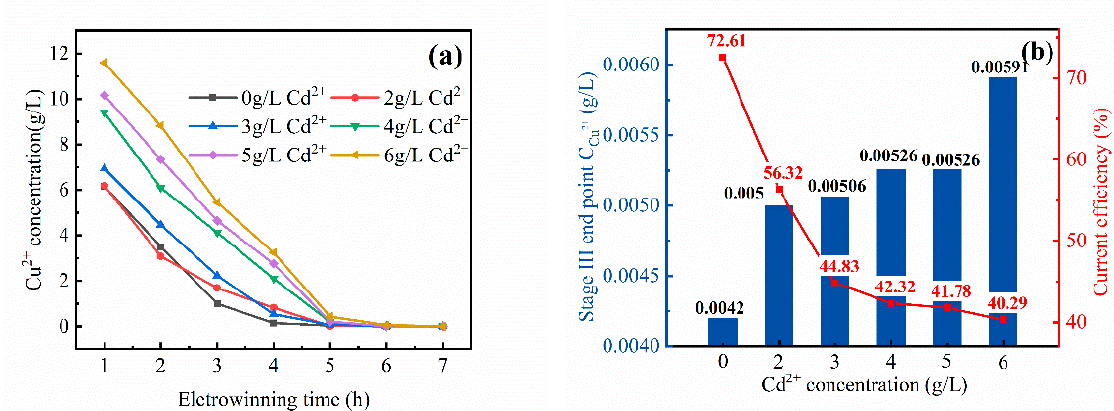
Figure 9. The curve of Cu concentration, endpoint content, and current efficiency in the third stage of the cyclone electrowinning process: ( a ) Cu concentration; ( b ) Endpoint content and current efficiency. Table 3. Copper purity of cathode with different Cd 2+ concentrations in the third stage.